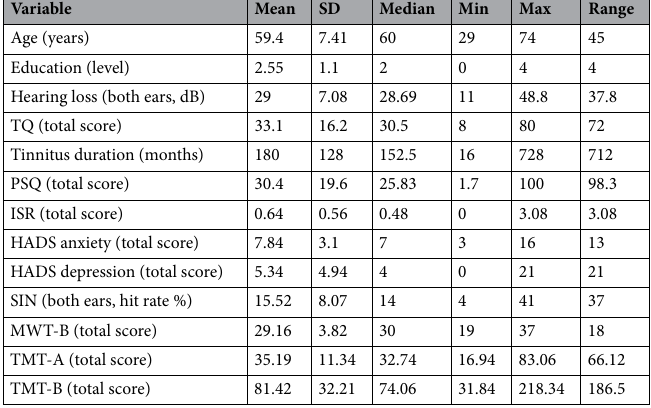
Table 1. Participant characteristics. SD standard